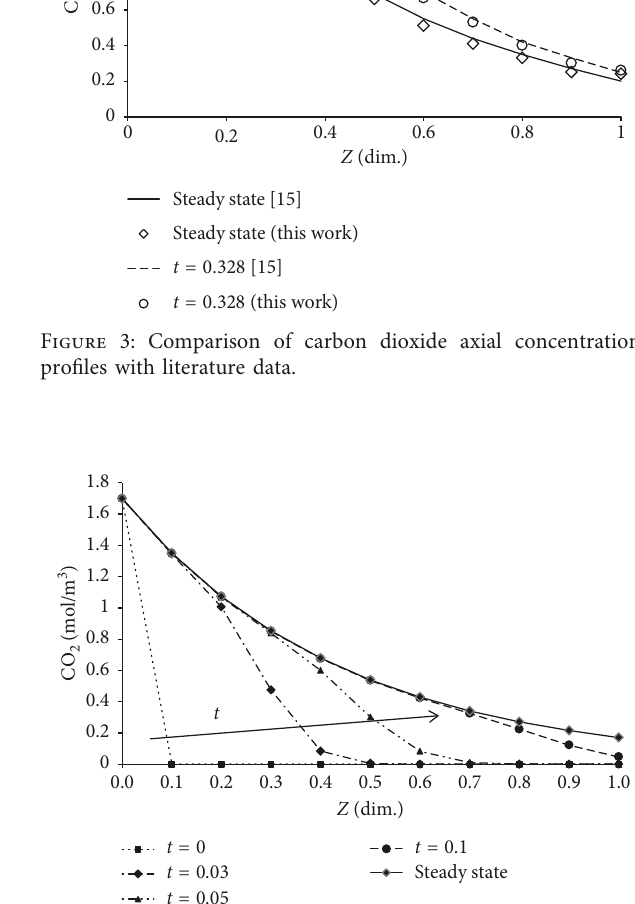
Figure 4: Carbon dioxide axial concentration profiles at different times.